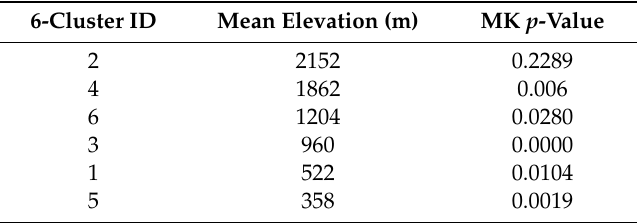
Figure 10. Seasonal (NDJFMA) snow depth HS in the 12 cluster regions that are found by the agglomerative hierarchical cluster analysis. The time series are calculated by averaging all within-cluster grid point values. The time series are smoothed using a Gauss low pass filter with a window size of 11 years. Table 3. Characteristics of the 6 clusters produced by agglomerative hierarchical clustering analysis and MK trend statistics of the averaged within-cluster grid point values of the seasonal (NDJFMA) snow depth HS (see Figure 9). The direction of all trends/tendencies is downward.